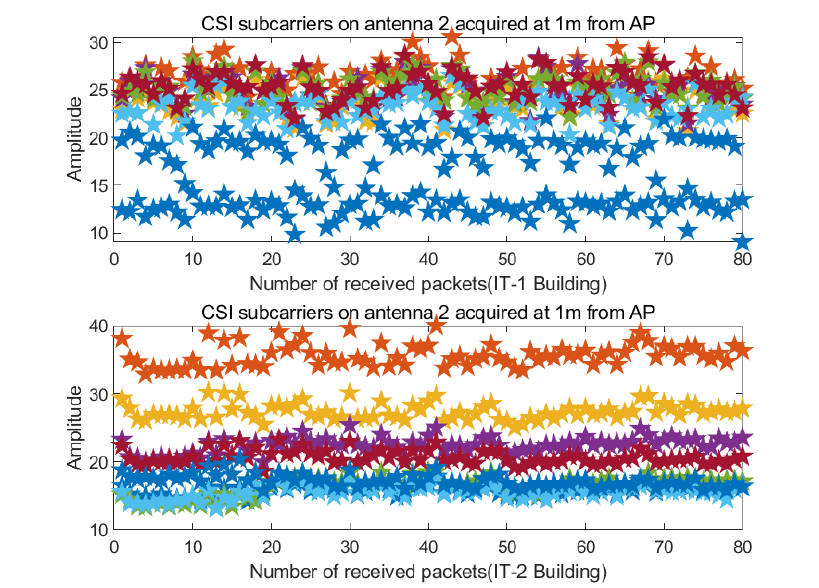
Figure 11. CSI subcarrier values obtained on antenna 2 in different indoor